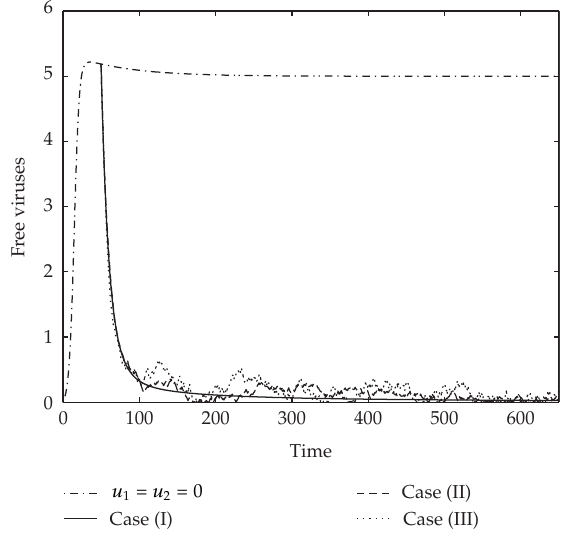
Figure 5: The evolution of free